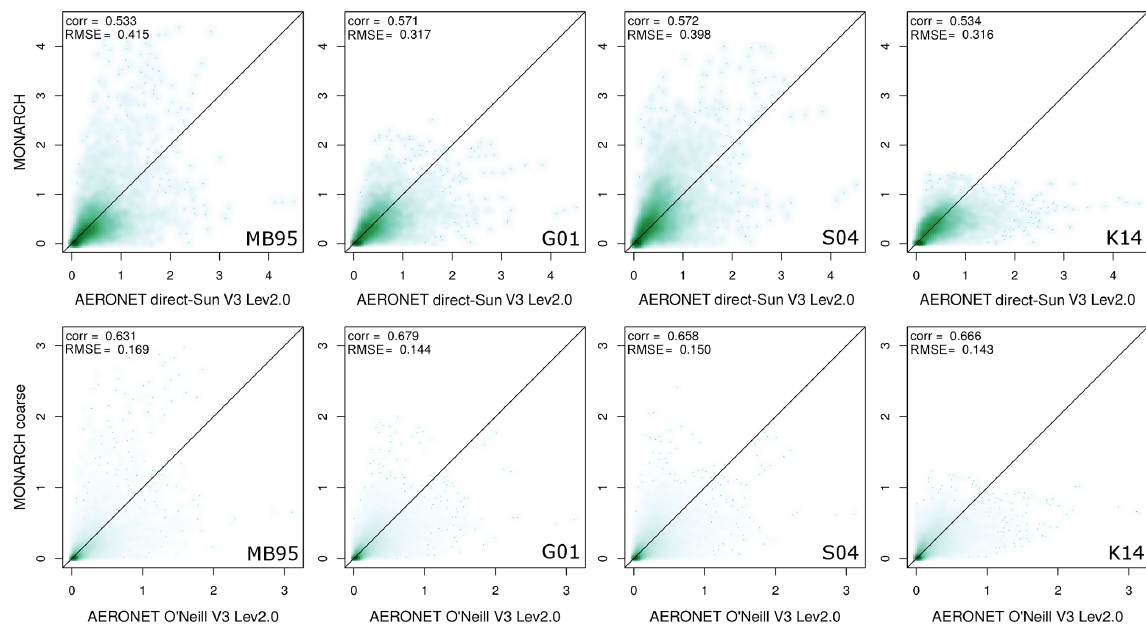
Figure C2. Scatter plots (top) of 3-hourly DOD estimated from AERONET direct-Sun V3 level 2.0 (AE < 0 . 3) and total DOD from MONARCH by experiment (MB95, G01, S04, and K14) for the stations listed in Appendix C; the bottom is the same as the top but for AERONET O’Neill V3 level 2.0 and coarse (diameters 1.2–20µm) MONARCH DOD. The Pearson correlation coefficient (corr) and RMSE are given in the